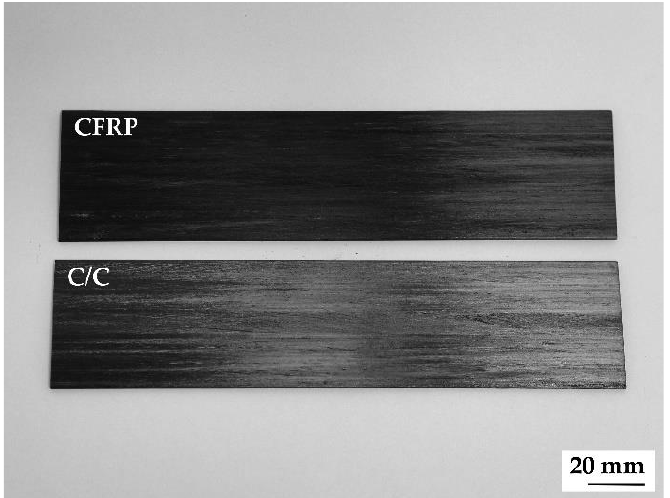
Figure 4. Macro images of the pultruded (CFRP composites) and pyrolyzed specimens (C/C composites).